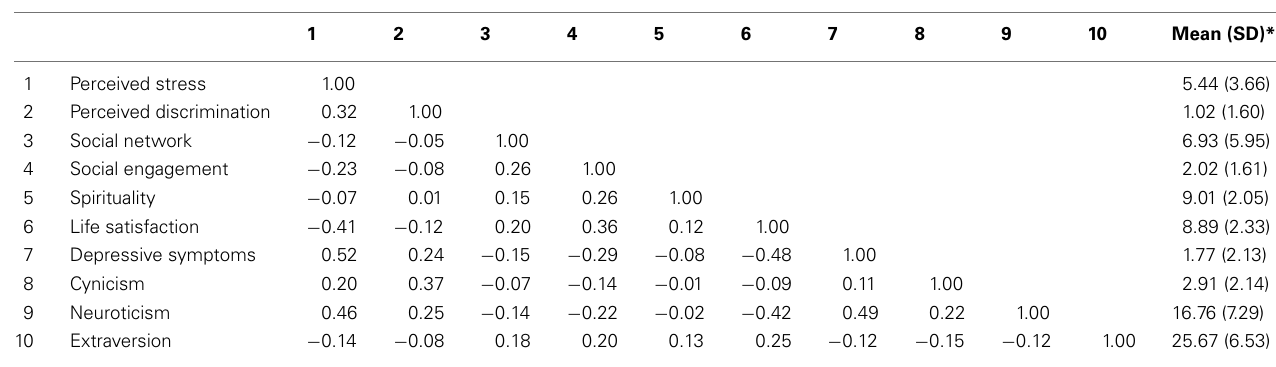
Table 1 | Correlation matrix, means, and SD of the psychosocial variables ( N = 4128).